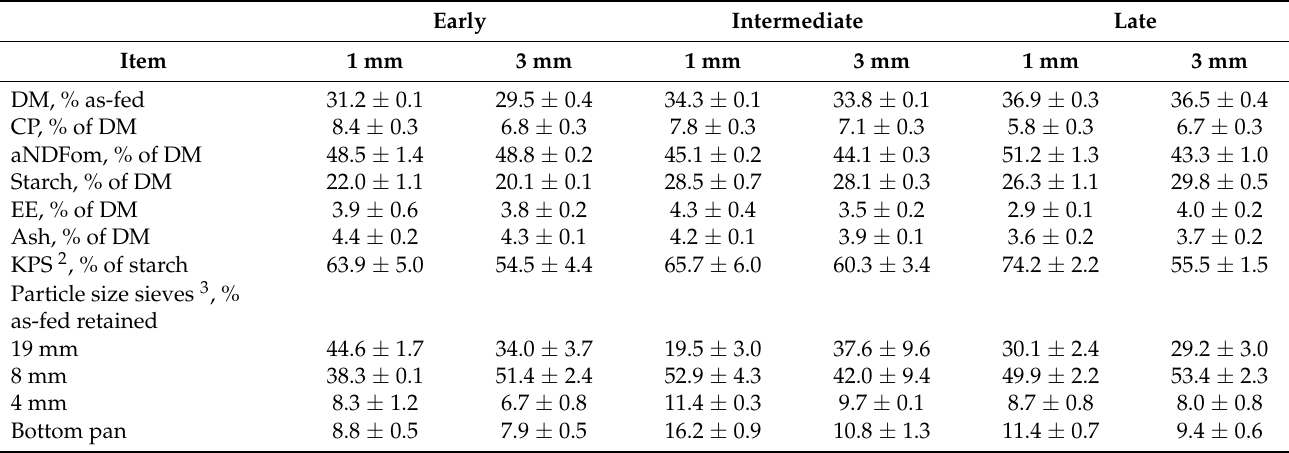
Table 1. Nutrient composition and particle size distribution of unfermented whole-plant maize silage ( n = 2 for each maturity by processing combination) 1